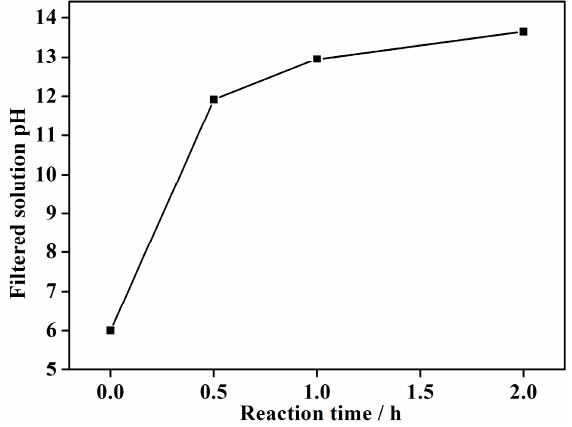
Figure 11. Effect of reaction time on the pH of filtered solution.